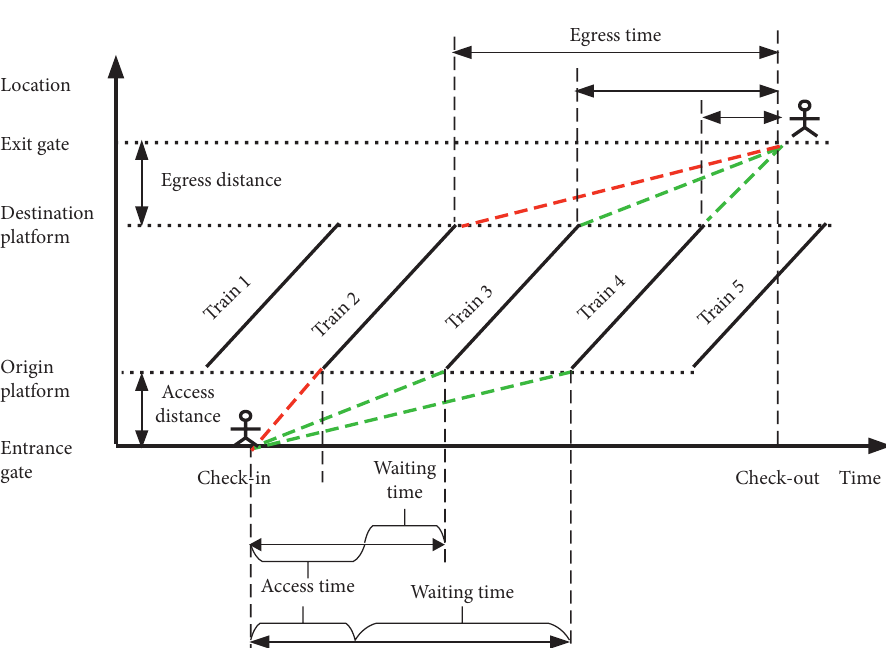
Figure 4: Diagram of passenger trips between Type-I